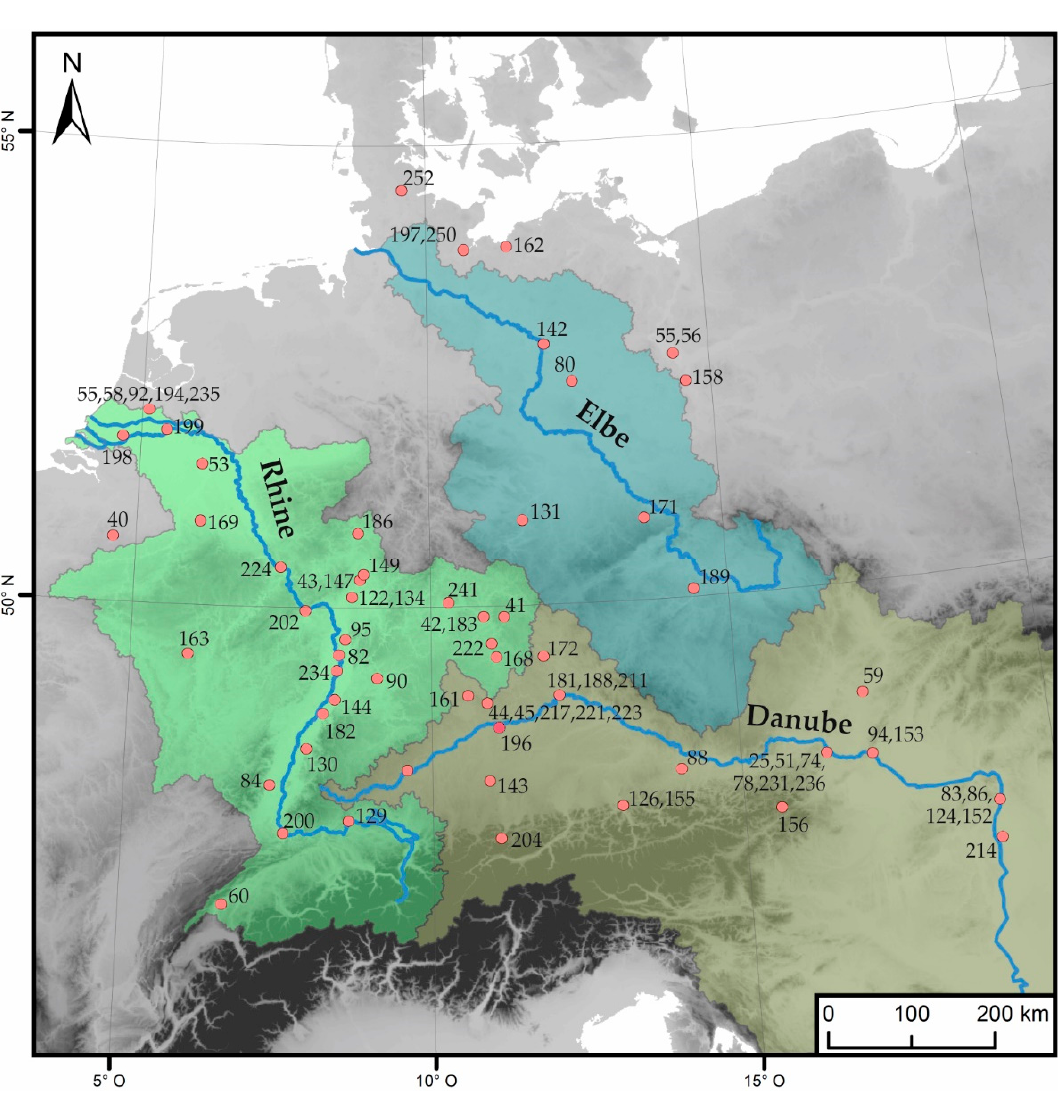
Figure 1. The Central European river catchments of the Danube, Elbe and Rhine with study locations, ranging from local to regional, mentioned in the text. The numbers refer to the list of references.